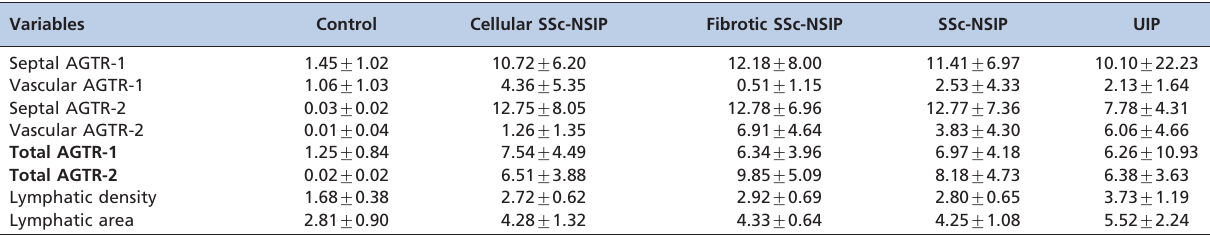
Table 2 - Summary of the morphometric results a .